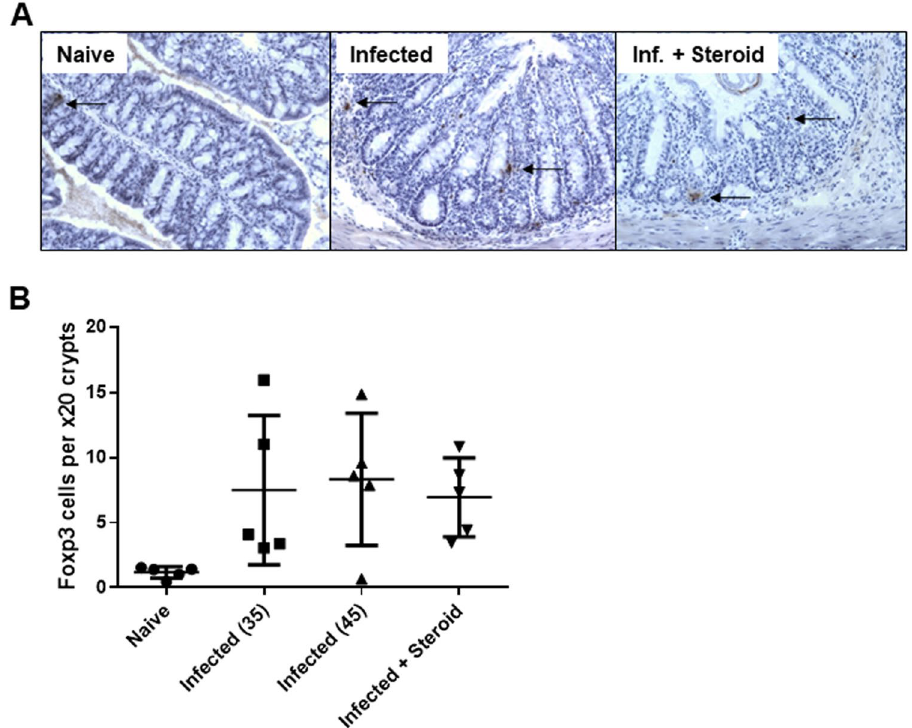
Figure 5. Hydrocortisone intervention does not increase Foxp3 + cells within the colonic tissue of T . muris infected mice. Immunohistochemistry staining for intracellular Foxp3 was performed on colonic cryosections (n = 5 per group). ( A ) Representative micrographs are shown (x200 magnification). Positive cells stained brown (arrows). ( B ) An increase in Foxp3 + cells was detected in all infected groups (data represented as the mean ± SEM). No significant difference in Foxp3 + cell numbers was found after steroid treatment (p = 0.61). Data representative of one